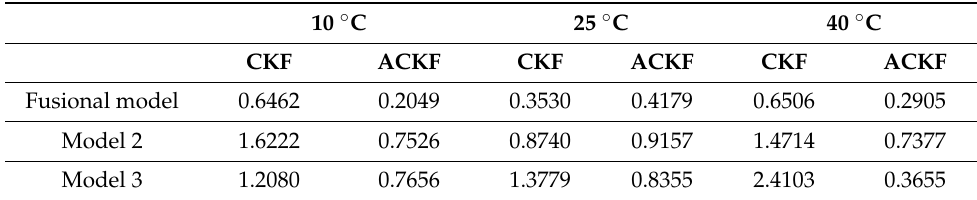
Figure 12. SOC estimation results for LFP battery by using: ( a ) CKF at 10 °C. ( b ) ACKF at 10 °C. ( c ) CKF at 25 °C. ( d ) ACKF at 25 °C. ( e ) CKF at 40 °C. ( f ) ACKF at 40 °C. Table 8. RMSE of SOC estimation for LFP battery (%).